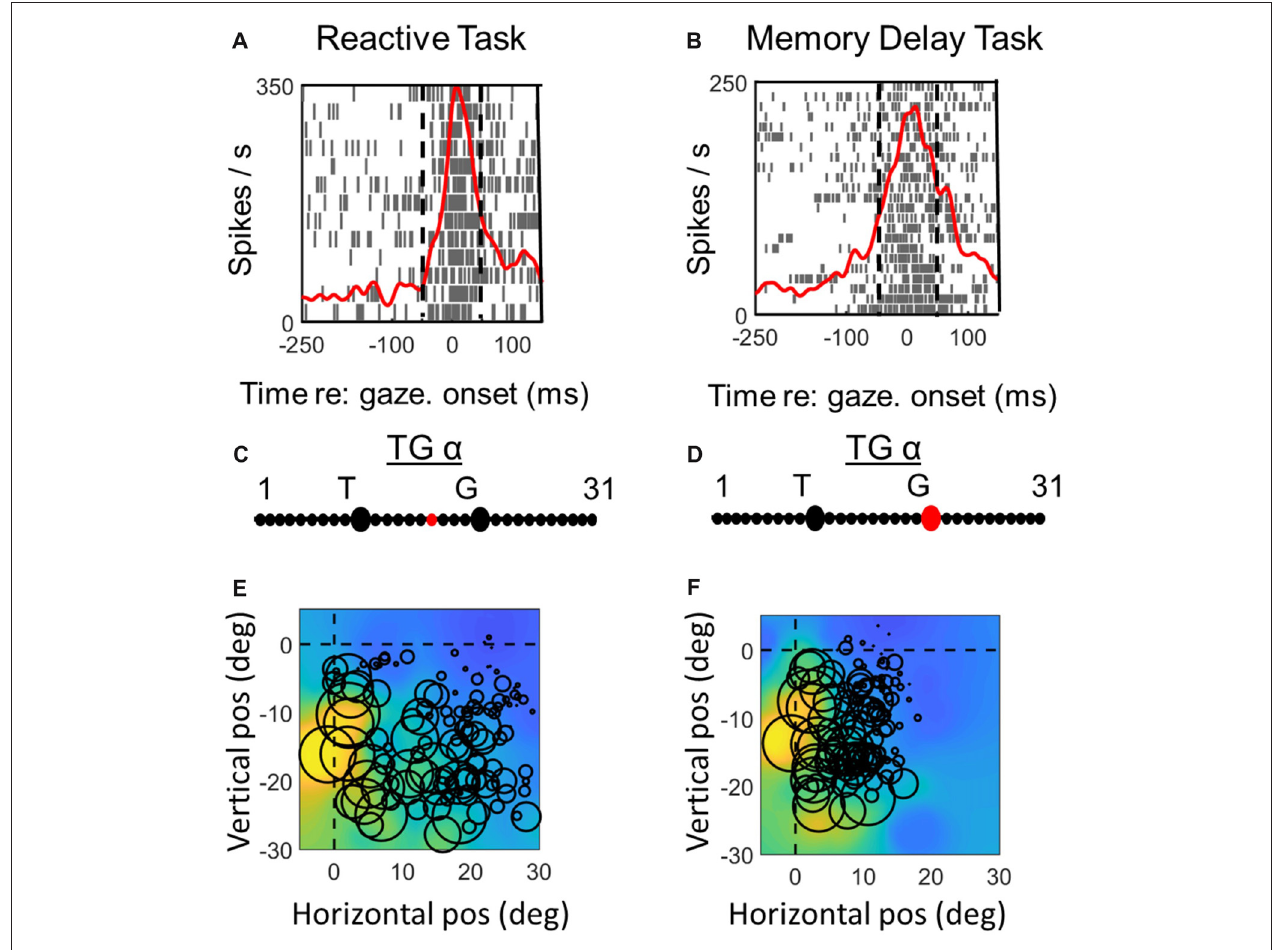
FIGURE 7 | Spatial analysis of motor activity during reactive task (left column) vs. memory delay task for one example motor neuron. Vertical dashed lines in (A,B) represent the fixed motor analysis windows ( − 50 to + 50 ms relative to gaze onset). Otherwise the plotting conventions are the same as in Figure 3